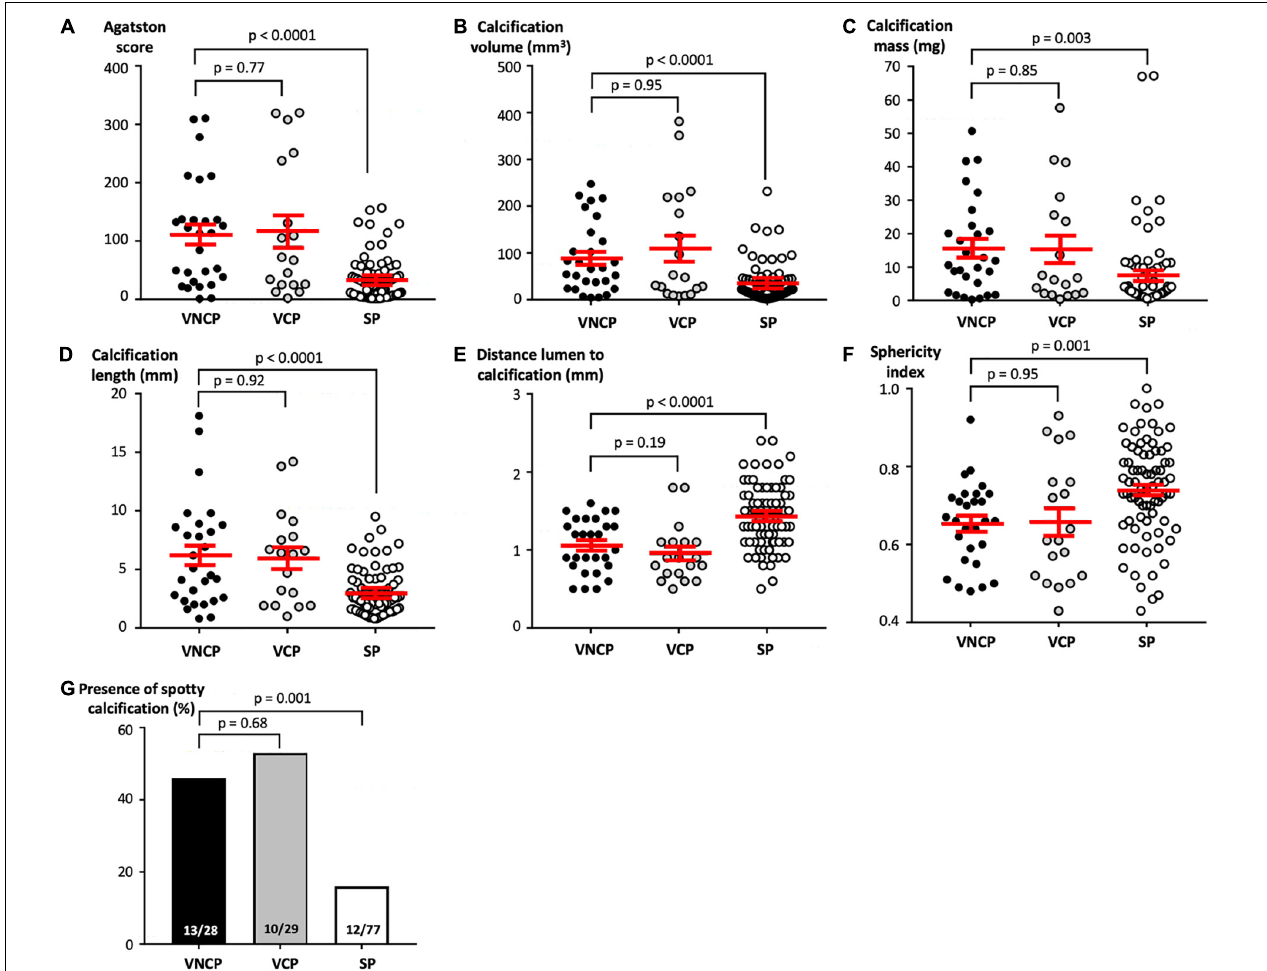
FIGURE 3 | Dot-plots comparing CCTA characteristics of VNCP, VCP, and SP. Comparisons of the Agatston score per calcified plaque (A) , the calcification volume in mm 3 (B) , the calcification masses in mg (C) , the calcification length in a longitudinal section in mm (D) , the calcification position on the wall measured by the distance in mm between the most intimal part of calcification and the vessel lumen (E) , the sphericity index defined as the ratio between the minimum diameter and the maximum diameter in an axial section (F) , and the presence of spotty calcification (percentage; G ). Quantitative variables are expressed as mean ± SEM. Abbreviations: CCTA, coronary computed tomographic angiography; SEM, standard error of the mean; SP, stable plaque; VNCP, vulnerable non-culprit plaque; VCP, vulnerable culprit